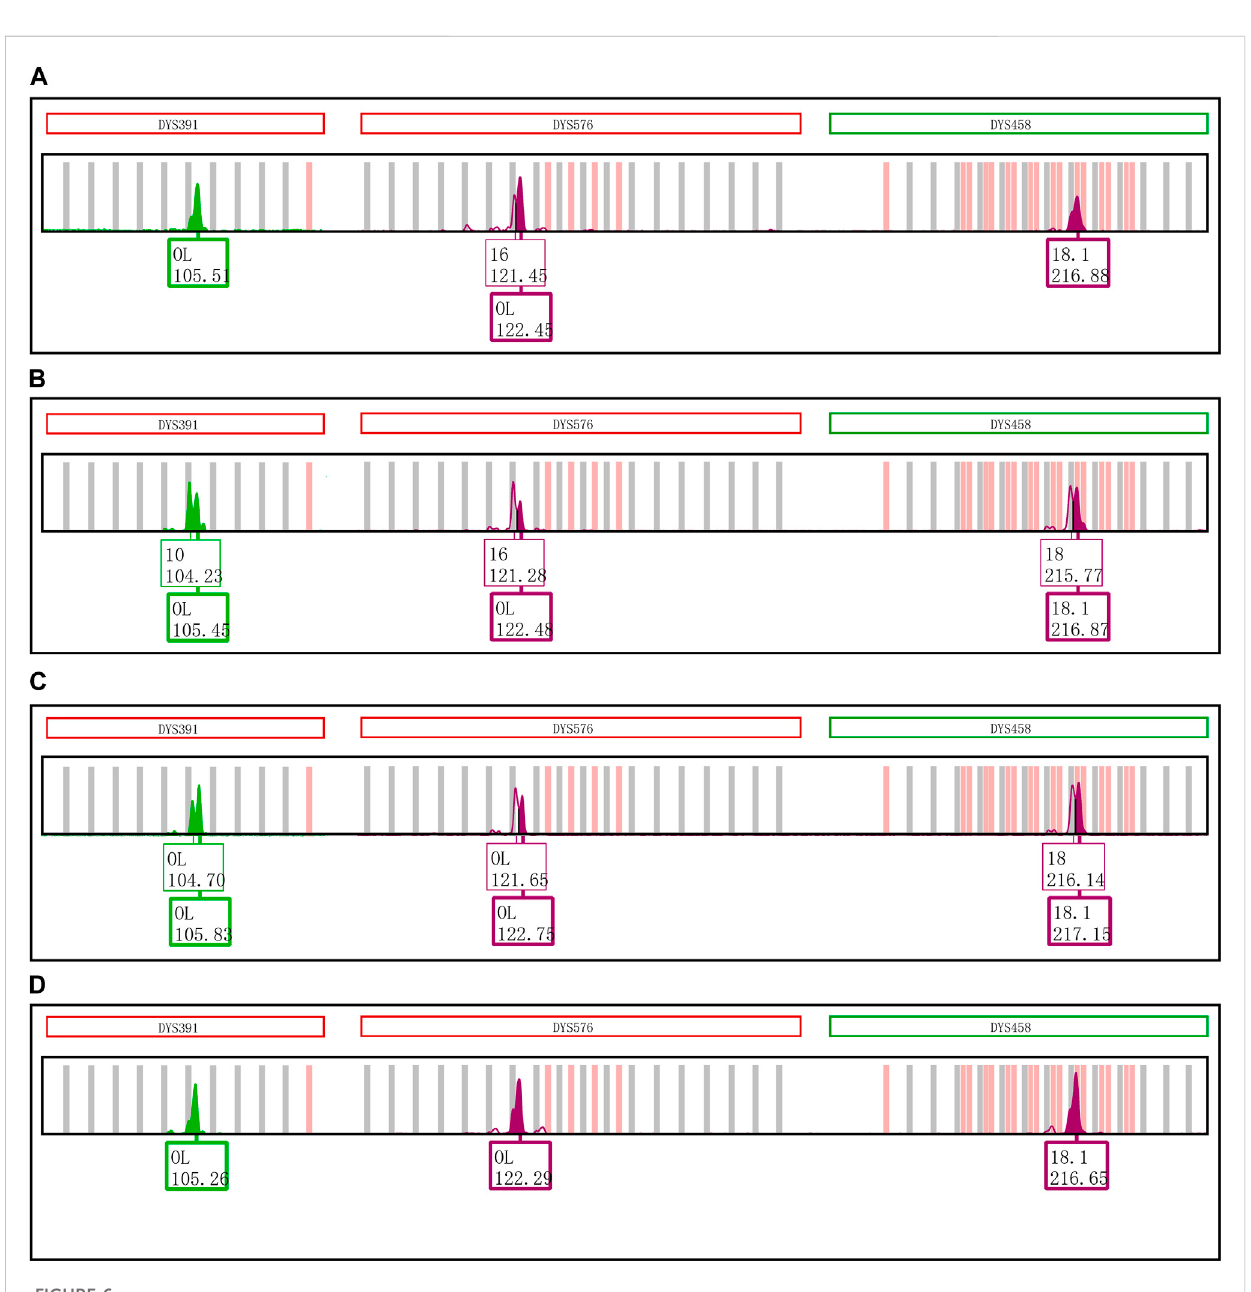
Changing the initial nucleotide at the 5 ′ end of reverse primers changes the proportion of excessive addition products. (A) PCR products of loci DYS391, DYS576 and DYS458 ampli fi ed by the original revers primers with an initial nucleotide A. (B) PCR products of loci DYS391, DYS576 and DYS458 ampli fi ed by the revised revers primers with an initial nucleotide T. (C) PCR products of loci DYS391, DYS576 and DYS458 that was ampli fi ed by therevisedreversprimerswith aninitialnucleotideC. (D) PCRproducts oflociDYS391, DYS576andDYS458that wasampli fi edbytherevisedrevers primers with an initial nucleotide